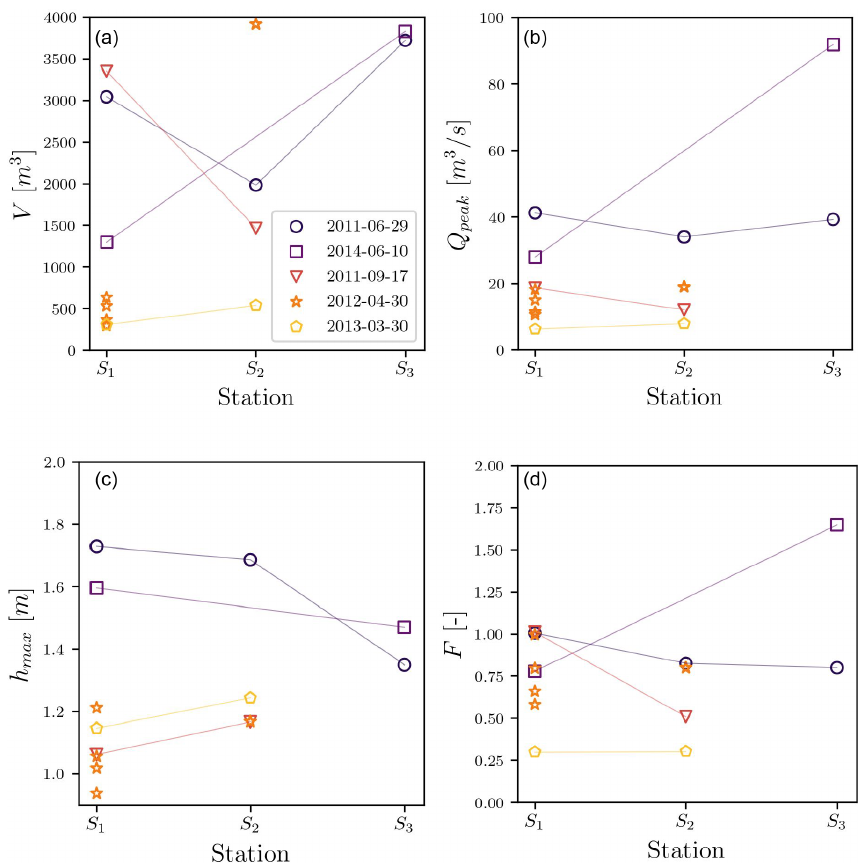
Figure 10. Temporal study for surges detected at two different sub-stations: (a) peak discharge over travelled distance (from the beginning of the channel), (b) volume over travelled distance, (c) maximum flow level and (d) Froude number. Please note that the date format in this figure is